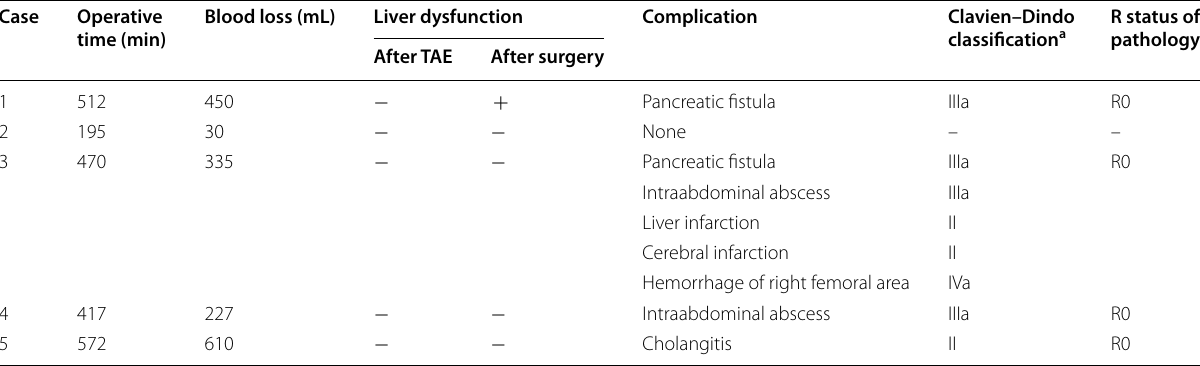
TAE trans-arterial catheter embolization a Dindo D, Demartines N, Clavien PA. Classification of surgical complications: a new proposal with evaluation in a cohort of 6336 patients and results of a survey . Ann Surg 2004;240:205–213